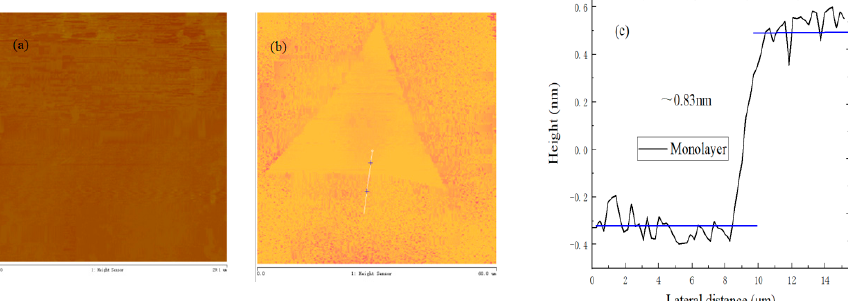
Figure 6. ( a ) Atomic force microscopy (AFM) topography of MoS 2 film; ( b ) AFM topography of triangular MoS 2 ; ( c ) AFM height profile of triangular MoS 2 (blue lines represent the average height of triangular MoS 2 under different position).